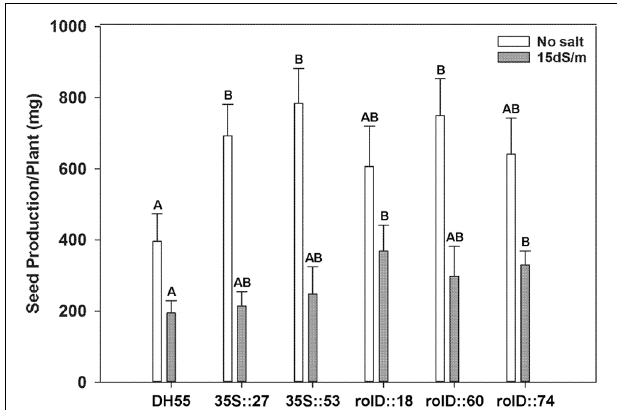
FIGURE 11 | The effect of acdS expression on seed production of camelina plants grown in the absence of, or presence of, salt (15 dSm − 1 ). Lines tested include wild-type C. sativa DH55 or independent, single insert, homozygous transgenic lines expressing the acdS gene under the control of the root-specific rolD promoter or the constitutive CaMV 35S promoter. Error bars indicate standard error ( n = 10 plants in control, five plants under moderate and four plants under severe salt stress). A two- way ANOVA and Tukey post-test were used to detect significant differences between groups. Capital letters above bars indicate values that are significantly different ( p < 0.05) between lines for each salt concentration.